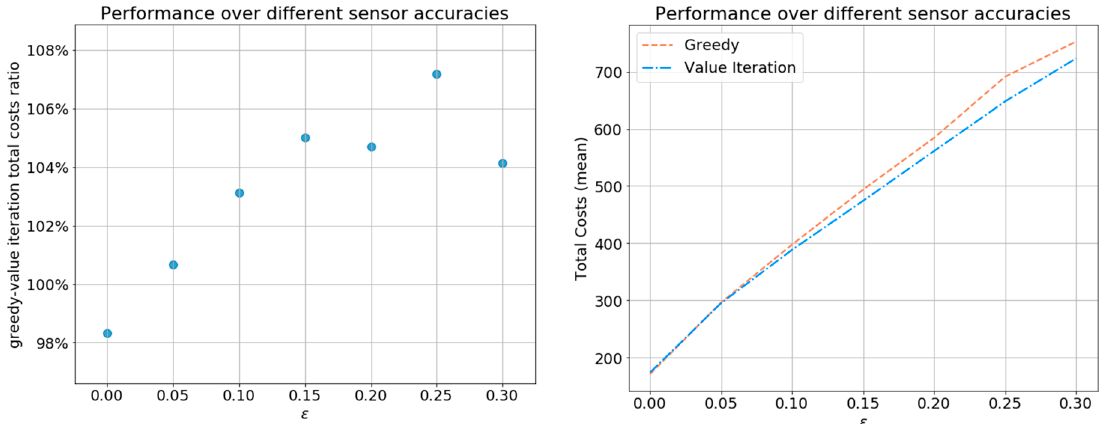
Figure 12. Total costs of the greedy policy and the value iteration policy over different sensor output probability matrices 𝐴 defined by 0 ≤ 𝜖 ≤ 0.3 (step size 0.05 ), averaged over 100 i.i.d. Monte Carlo simulations.